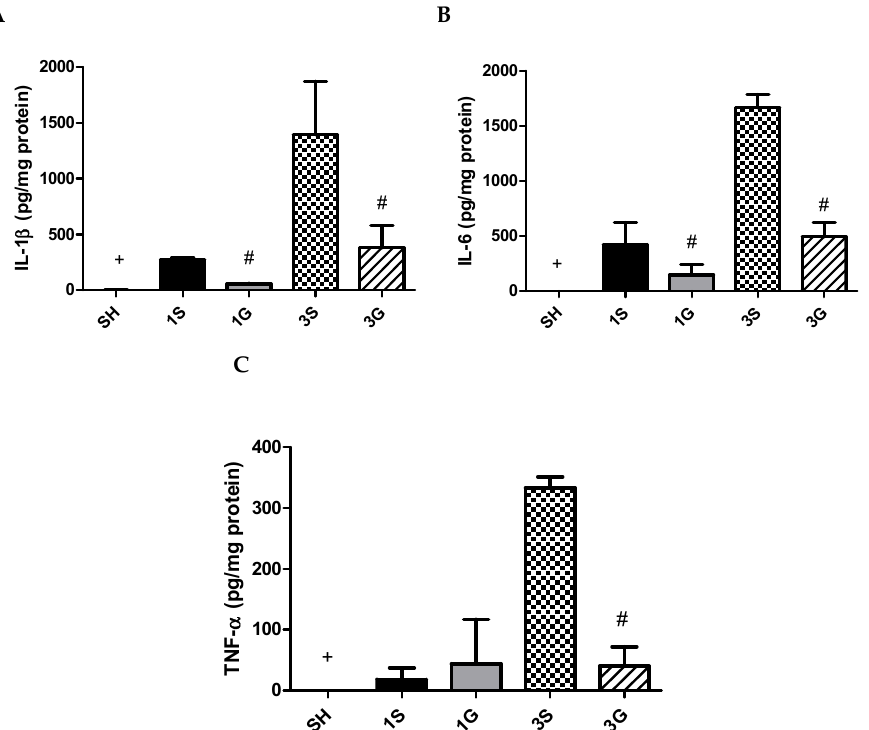
Figure 2. Concentrations of inflammatory cytokine ( A ) IL-1 β , ( B ) IL-6 and ( C ) TNF- α in peritoneal lavage fluid. IL-1 β , interleukin-1 β ; IL-6, interleukin-6; TNF- α , tumor necrosis factor- α . SH, sham group; 1S, saline-injected group sacrificed 1 day after the gastrectomy; 1G, GLN-injected group sacrificed 1 day after the gastrectomy; 3S, saline group sacrificed 3 days after the gastrectomy; 3G, GLN-injected group sacrificed 3 days after the gastrectomy. n = 8 for each group. Values are presented as the mean ± SEM. Differences among groups were analyzed by a one-way analysis of variance (ANOVA) followed by the Bonferroni post-hoc test. + Significantly differs from the SH group. # Significantly differs from the S group at the same time point ( p < 0.05). 3.6. Expression of Macrophage Infiltration Markers and Inflammatory Mediator mRNAs in Epididymal Tissues after the Gastrectomy